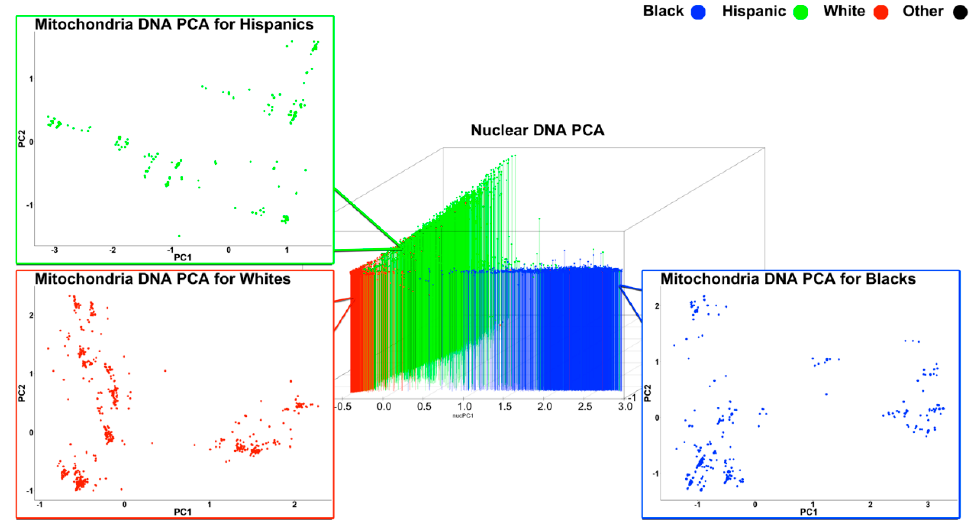
Figure 2. Intra-ethnic principal component analysis on mitochondrial SNPs. Red indicates Whites; Blue indicates Blacks; and Green indicates Hispanics.